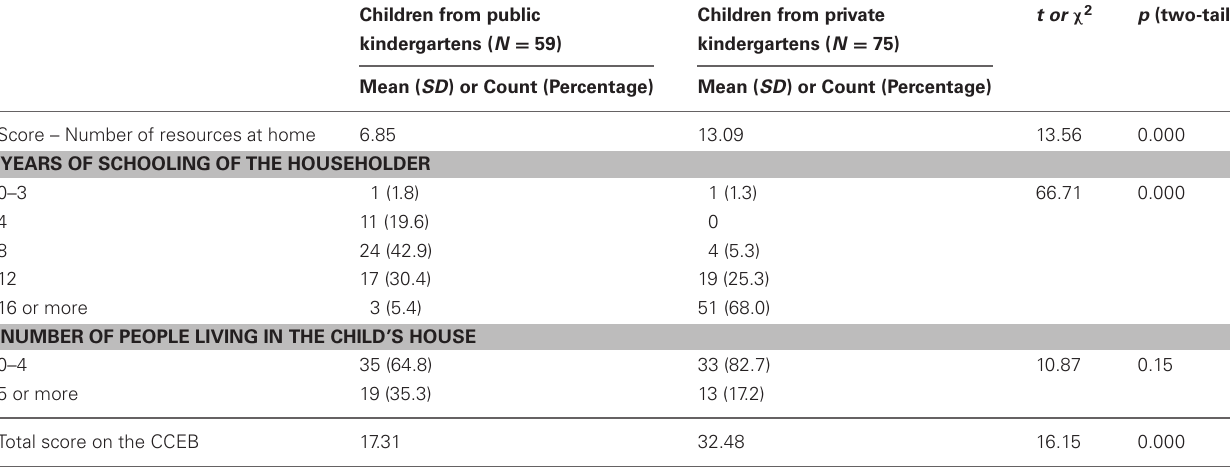
Table 1 | Socioeconomic characteristics of children from high and low